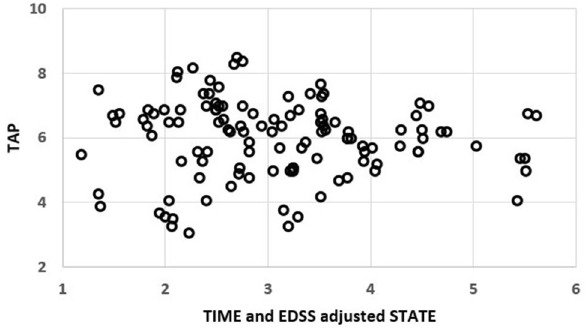
Figure 5. Scatter plot of TAP and TIME and EDSS adjusted STATE (R 2 < 0.01, p =